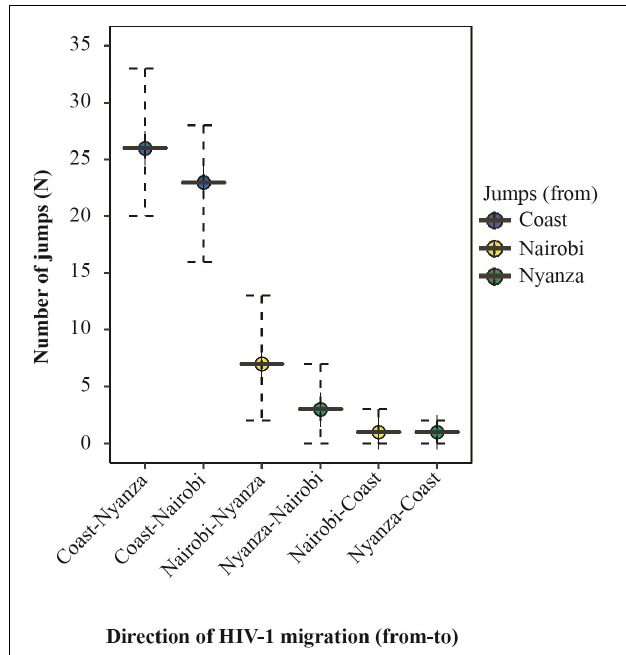
FIGURE 5 | Summary of the expected number of HIV-1 migration between geographic regions in Kenya. Summary of the median number (and 95% HPD interval) of Markov jumps inferred with a uniform sampling of geographic regions. Plots represent HIV-1 exchange between provinces. Plots are colored by the “source” location as shown in the legend. Only statistically significant transitions [Bayes Factor (BF) ≥ 3] are plotted.